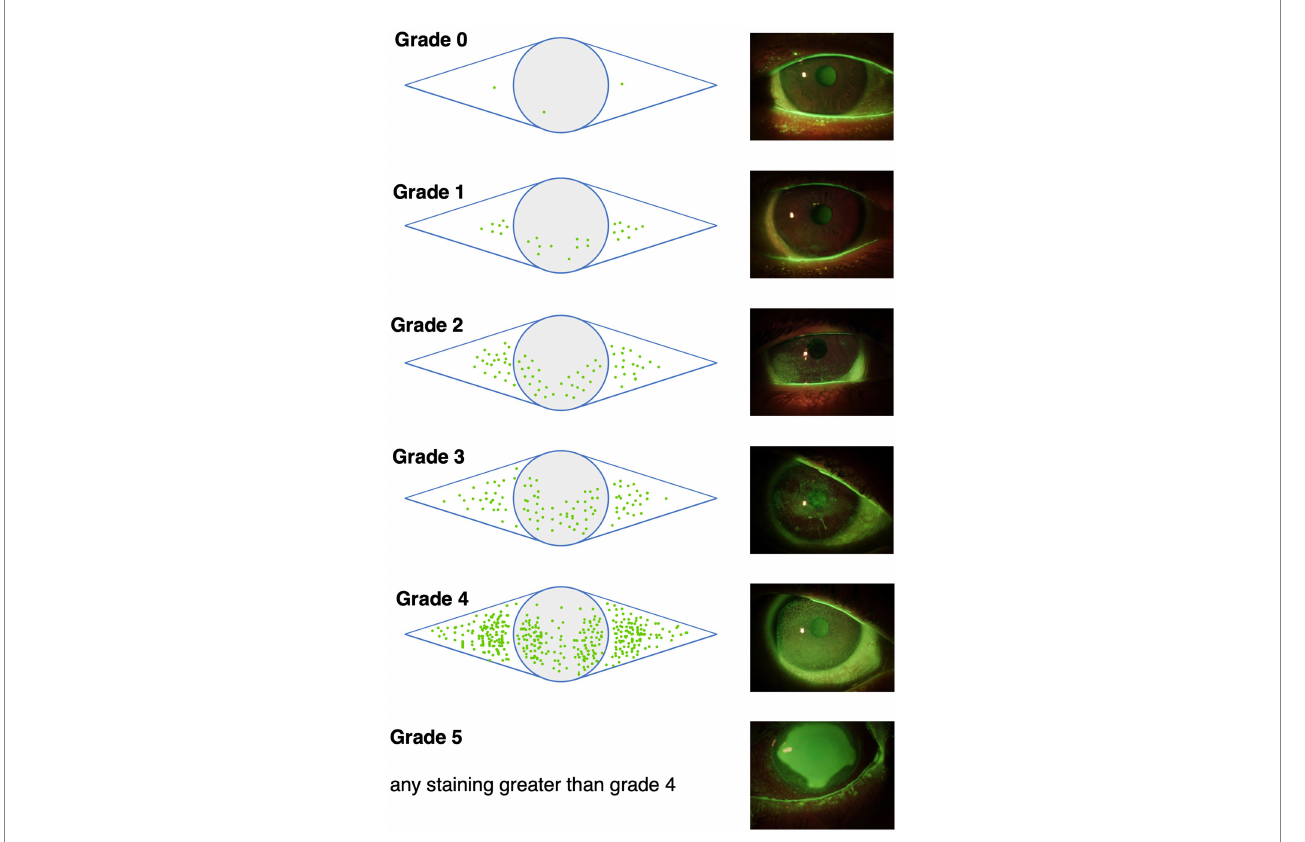
FIGURE 3 The Oxford grading scheme differentiates 5 grades of corneal and conjunctival fluoresceine staining. Image adapted from Bron et al. (90).